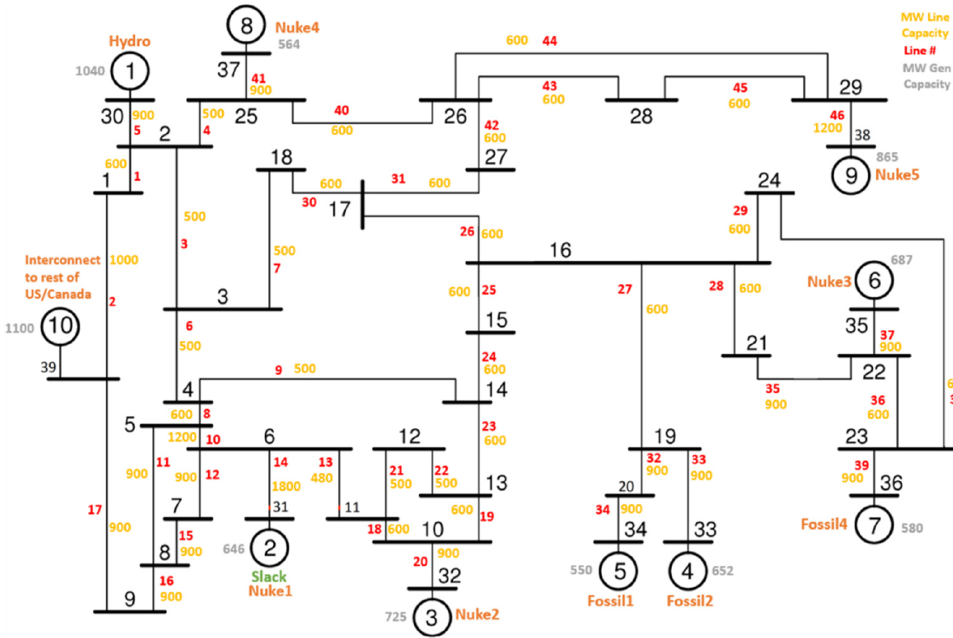
Figure 12. System Diagram (IEEE 39-Bus System) with Bus Number (black), Generator Number (black encircled), Line Number (red), Line MW Capacity (yellow) and Generators MW Capacity (gray).